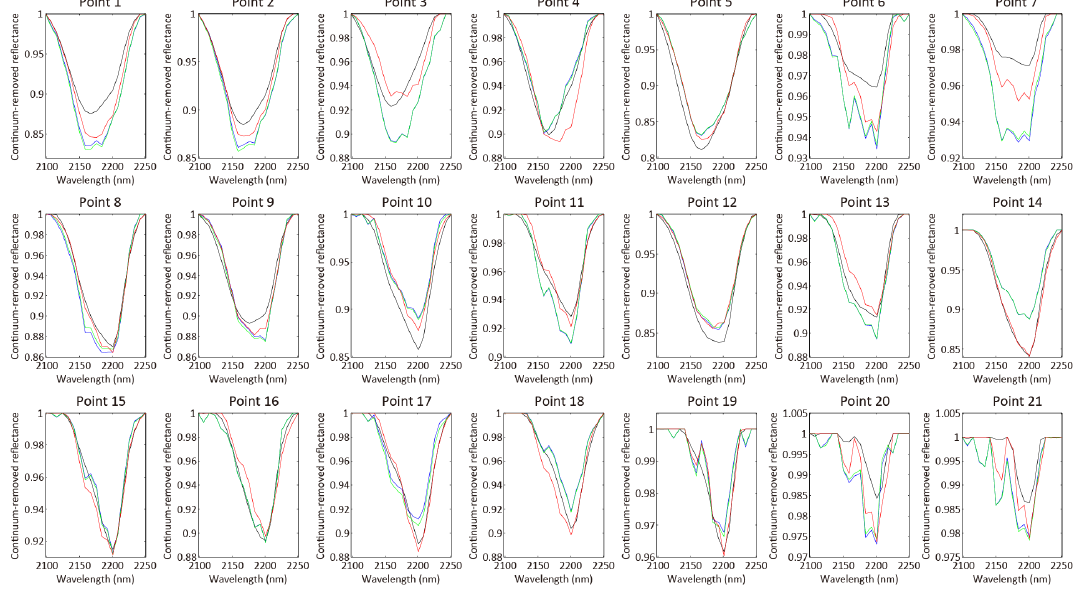
Figure 6. Comparison of continuum-removed spectral signatures between ( black ) reference; ( blue ) bicubic interpolation; ( green ) GSA; and ( red ) CNMF images at 21 points [37].